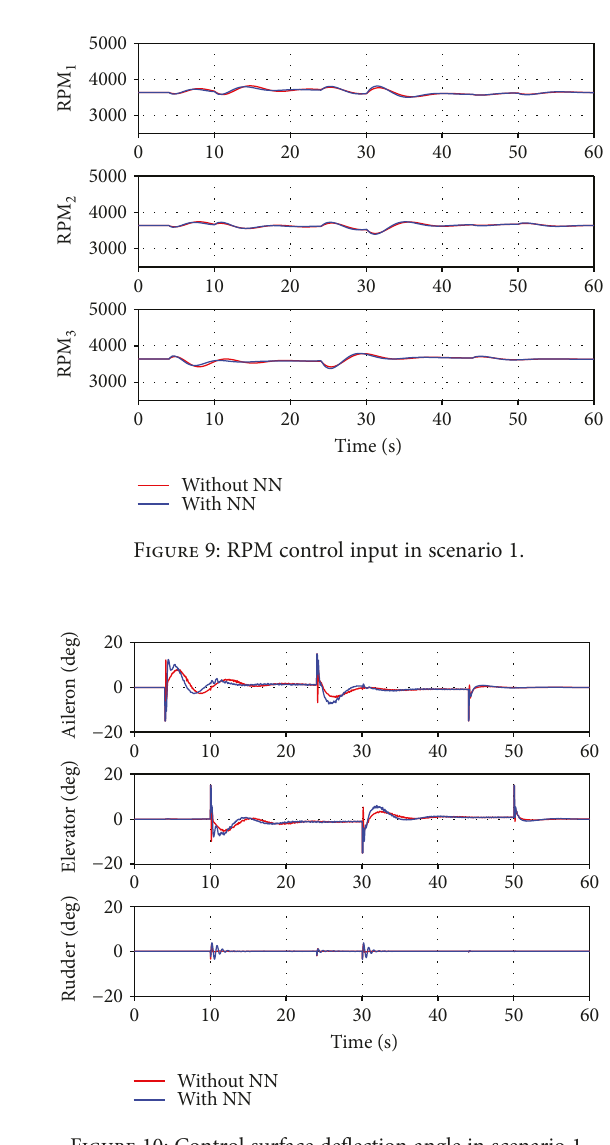
Figure 10: Control surface de fl ection angle in scenario